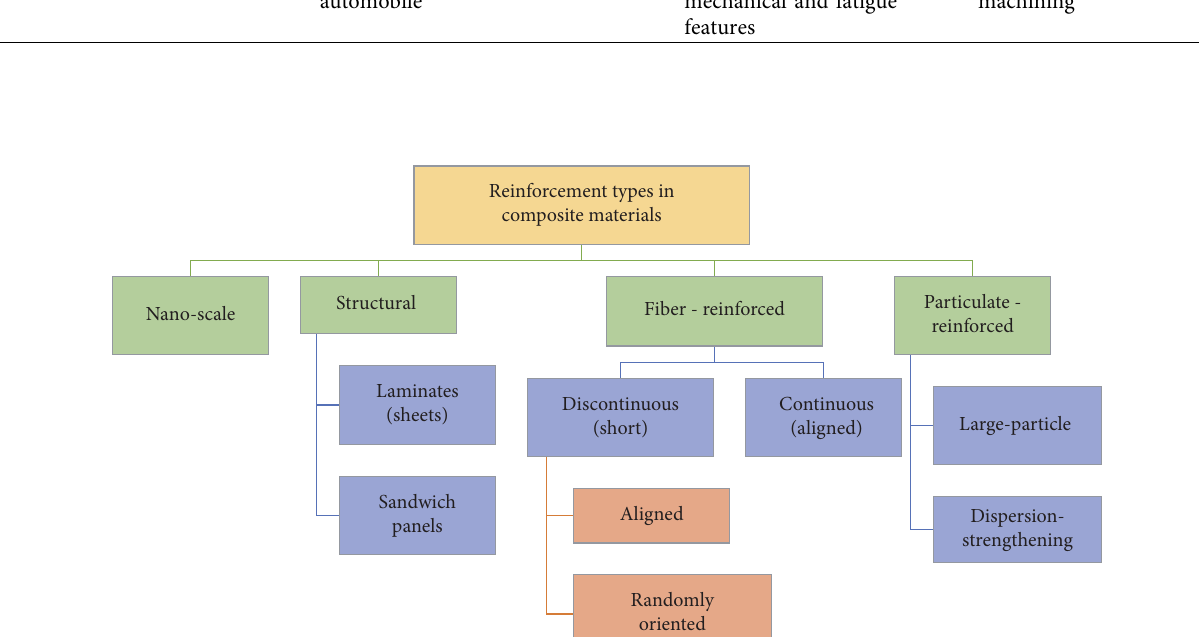
Figure 2: MMC classification is based on reinforcement type, reproduced with permission from ref. [42], copyright 2018, Wiley Online